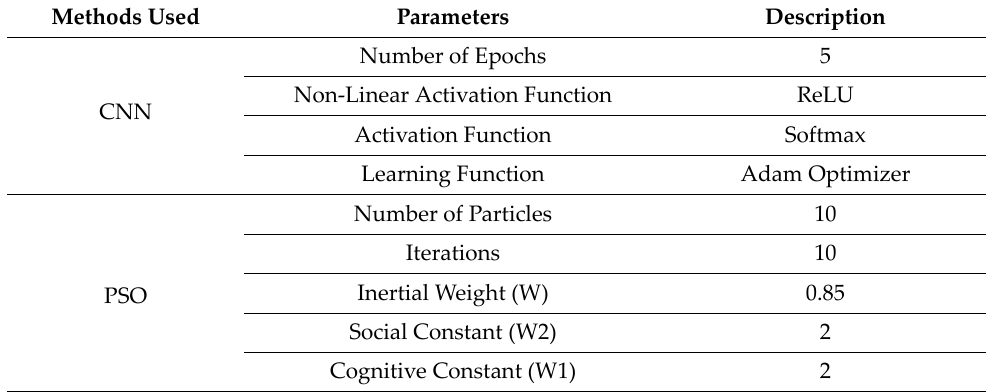
Table 4. Hyperparameters of CNN and PSO. Methods Used Parameters